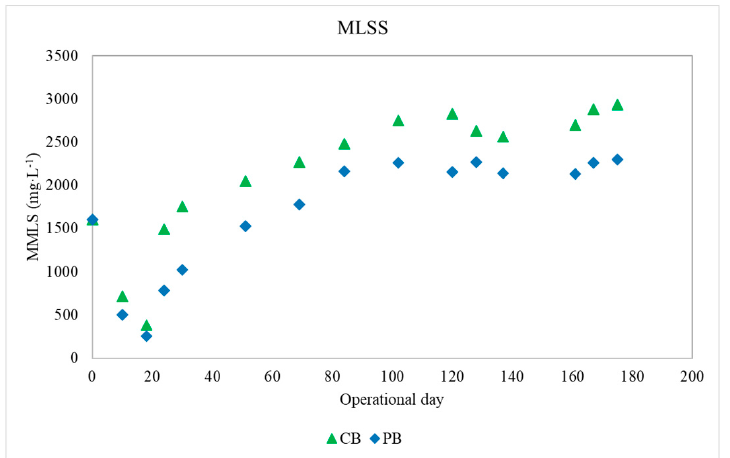
Figure 2. Biomass concentration expressed as mix liquor suspended solids (MLSSs) for CB (green triangle) and PB (blue diamond).